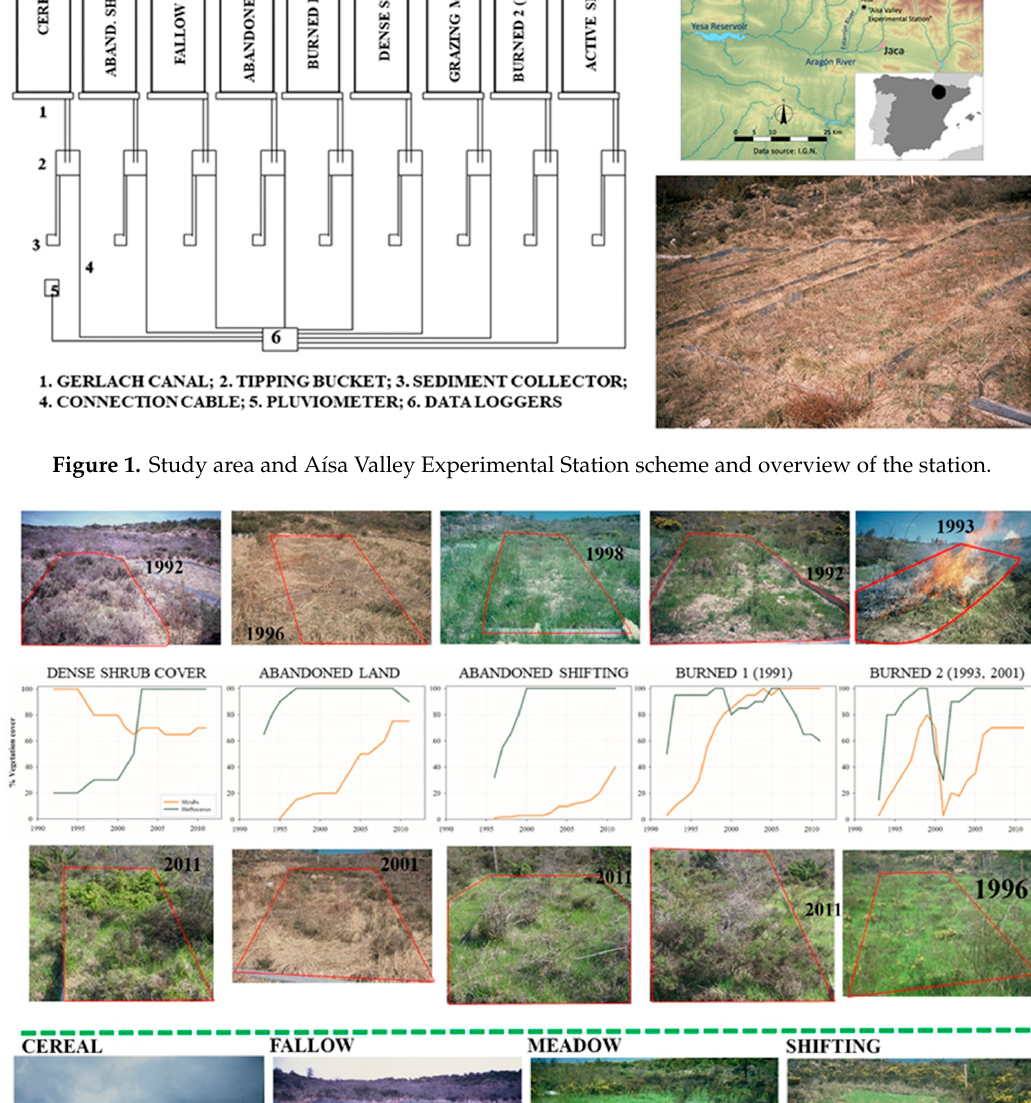
Water 2019 , 11 , 976 4 of 17